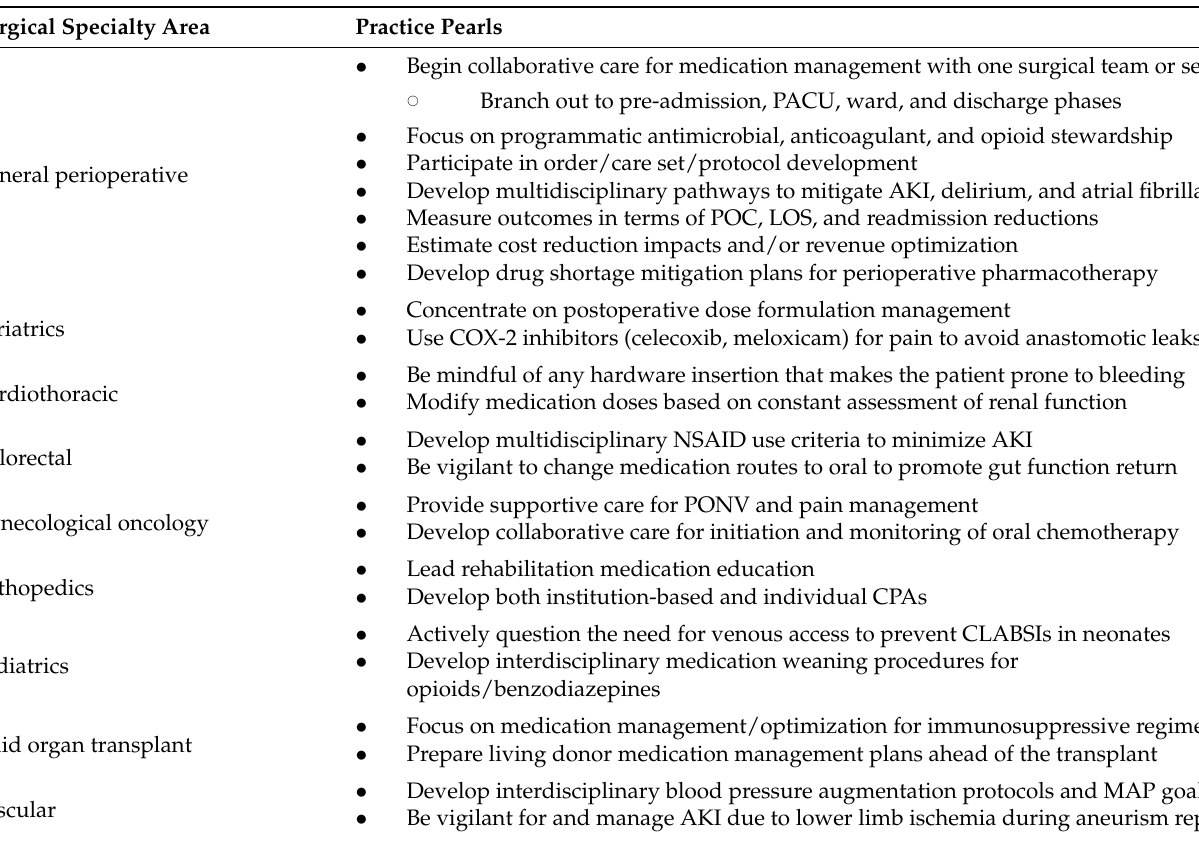
Table 6. Pharmacotherapy “practice pearls” for each specialty area.